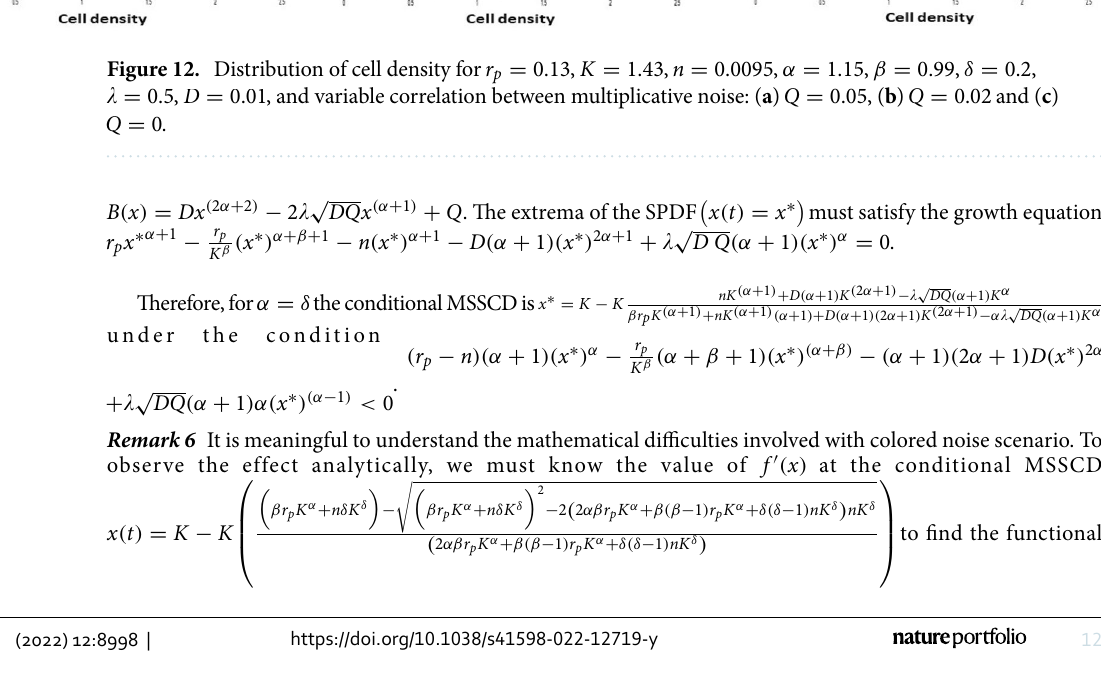
0.13 , K 1.43 , n 0.0095 , α = = =